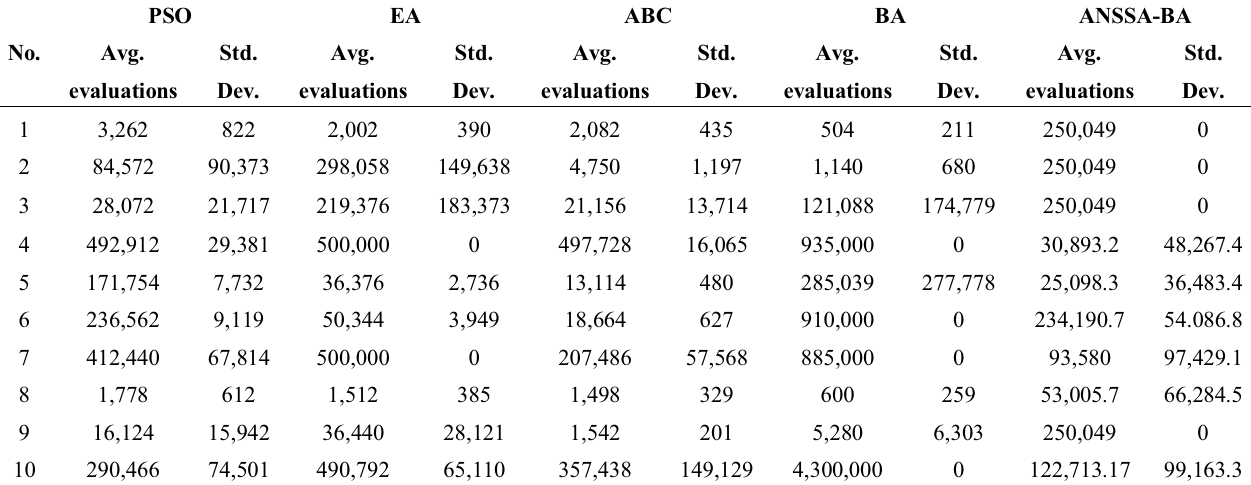
Table 9. Average evaluation of proposed algorithm compared with other well-known optimization